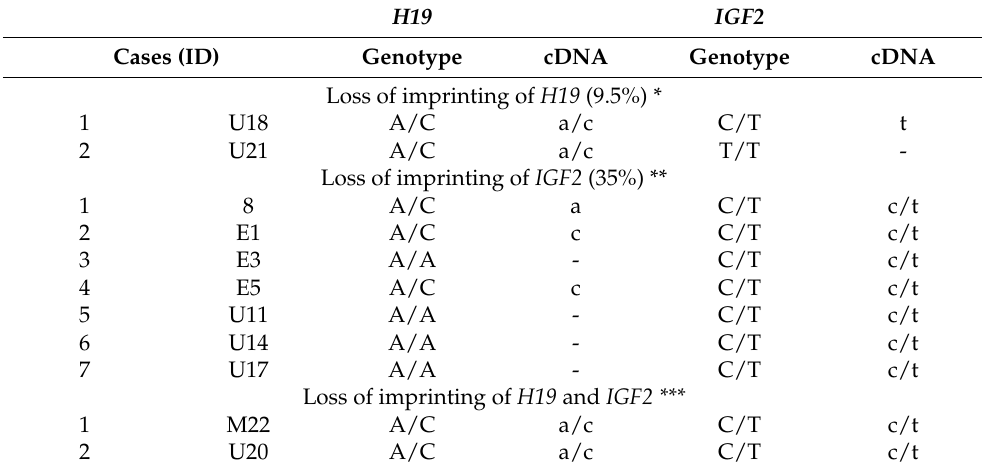
Table 1. Loss of H19 and IGF2 imprinting in RSA decidua.